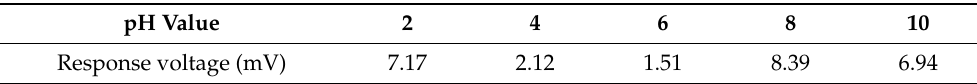
Table 3. The potential of the ENIG in pH 2 to 10 buffer solutions.